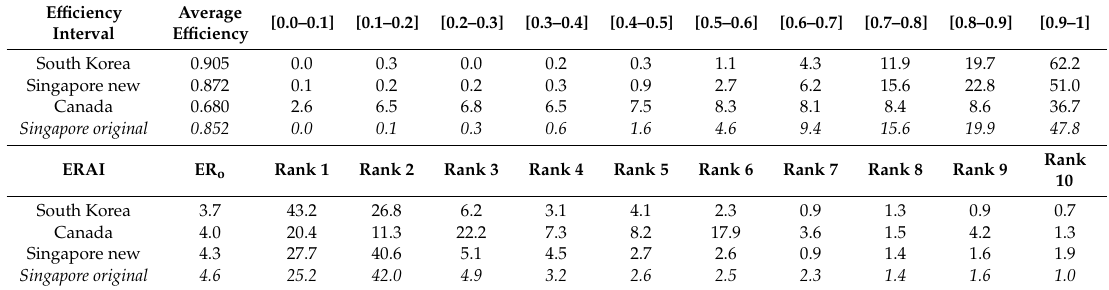
Table 12. Results for scenario 1. The e ffi ciency acceptability interval indices (EAIIs) and the ERAIs are given in %. Even though Singapore does not get the first position, having 8% of solar photovoltaic (PV) generation improves its electricity supply